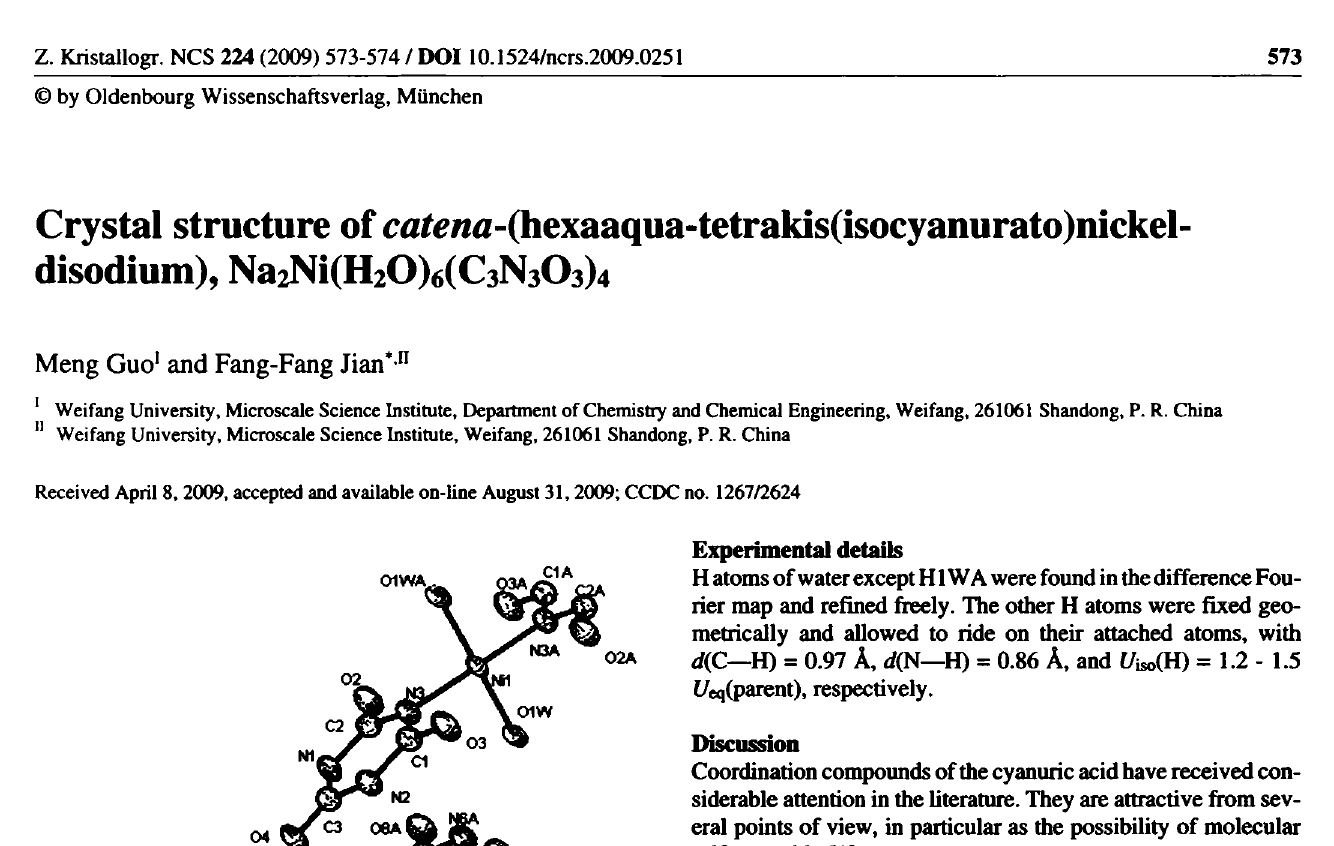
Table 1. Data collection and handling.